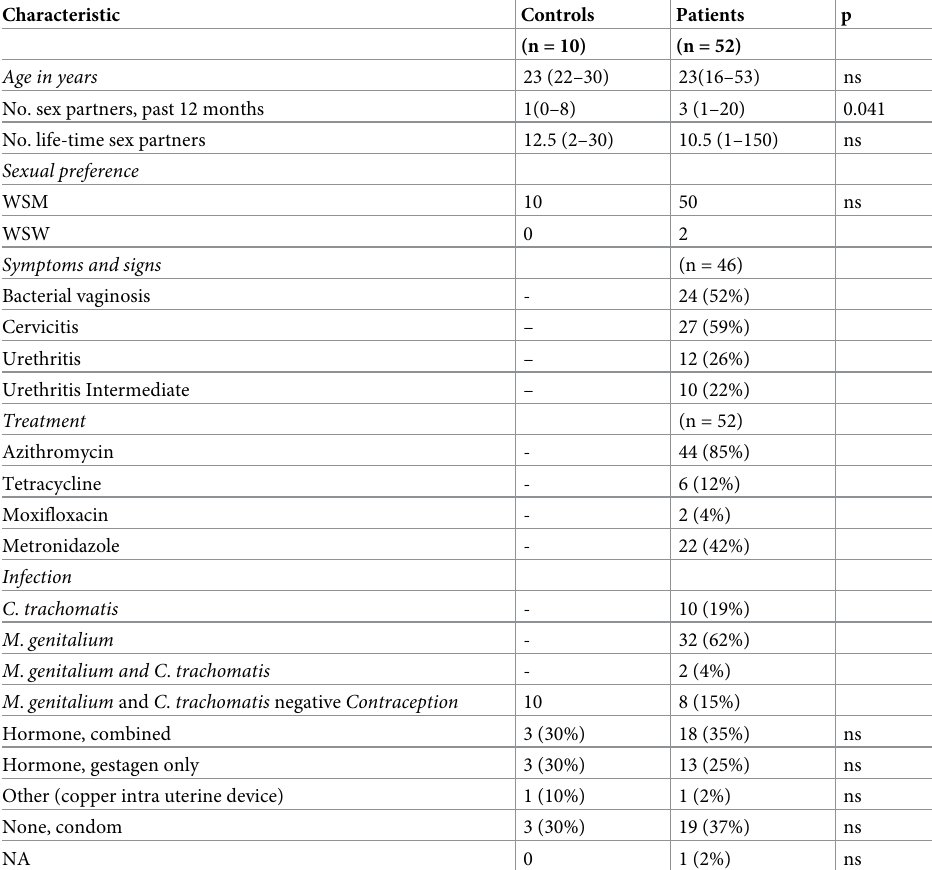
Table 1. Characteristics of the included patients and